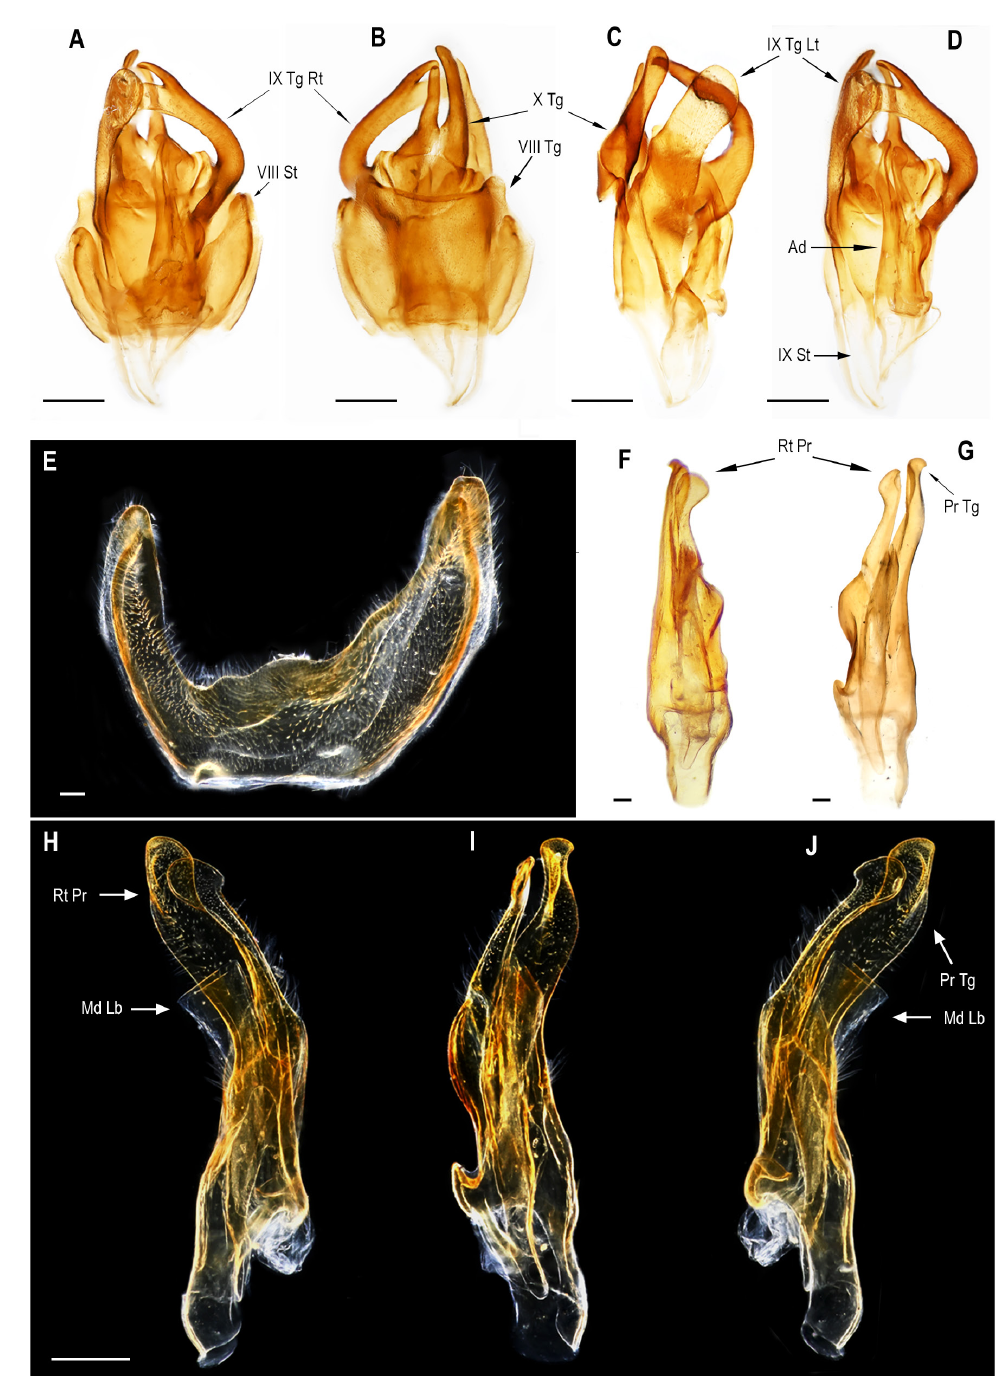
Fig 3. Micro images (brightfield and darkfield) of Trypheridium kashmiricum sp. nov. ♂, holotype (KUIC 0013), terminal segments genitalia. A . Ventral view. B . Dorsal view. C . Lateral view. D . Ventral view with IX sternite and tergite removed. E . IX th sternite. F . Aedeagus in ventral view. G . Aedeagus in dorsal view. H . Aedeagus in lateral view, left side. I . Aedeagus in dorso-lateral view. J . Aedeagus in lateral view, right side. Abbreviations: VIII St = sternite VIII; VIII Tg = tergite VIII; IX St = sternite IX; IX Tg = tergite IX; IX Tg Lt = left blade of tergite IX; IX Tg Rt = right blade of tergite IX; X Tg = tergite X; Ad = aedeagus; Md Lb = median lobe; Pr Tg = prolongation of tegmen; Rt Pr = right paramere. Scale bars: A–D, H–J = 0.5 mm; E–G =